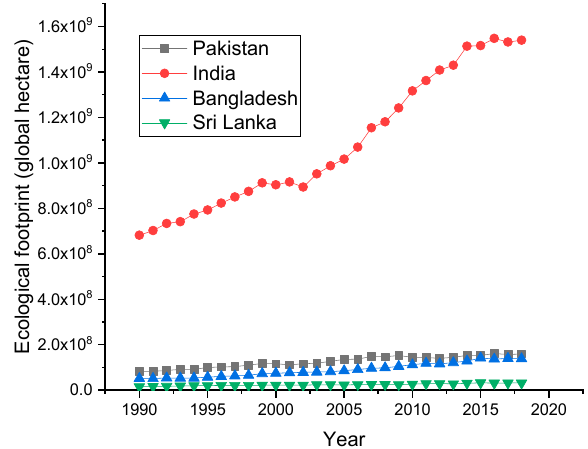
Figure 1. Trends of ecological footprints (Source: Global Footprint Network).